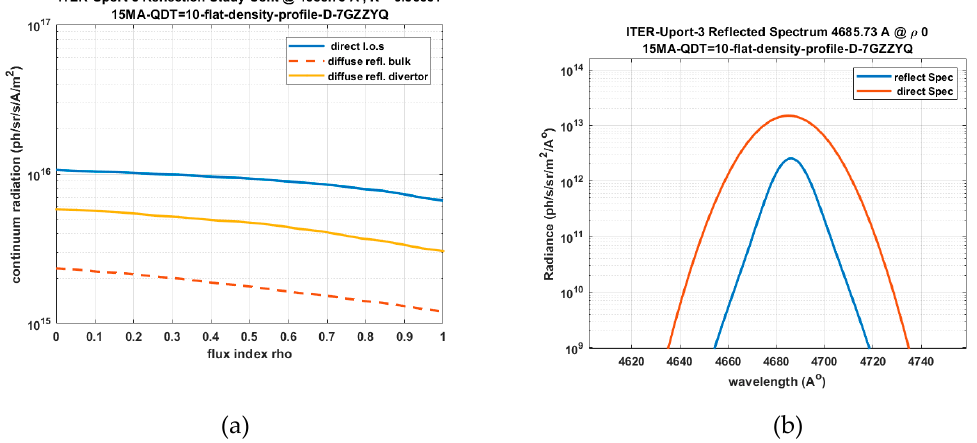
Figure 23. ( a ) Continuum radiation reflection study for ITER Uport-3 showing direct continuum radiation, blue line, reflected divertor continuum, green line and reflected bulk continuum, dashed red-line. The electron density in the divertor region is assumed to be 10 x on-axis electron density; ( b ) red line: Direct ACX (active charge exchange) HeII spectrum, blue line: Accumulated spectrum from reflected ACX spectra emitted along beam path. A semilogarithmic presentation is chosen to illustrate the non-Gaussian character of the accumulated sum spectrum. The peak amplitude of reflected spectrum is 11% of direct amplitude (Be wall reflection 40%).